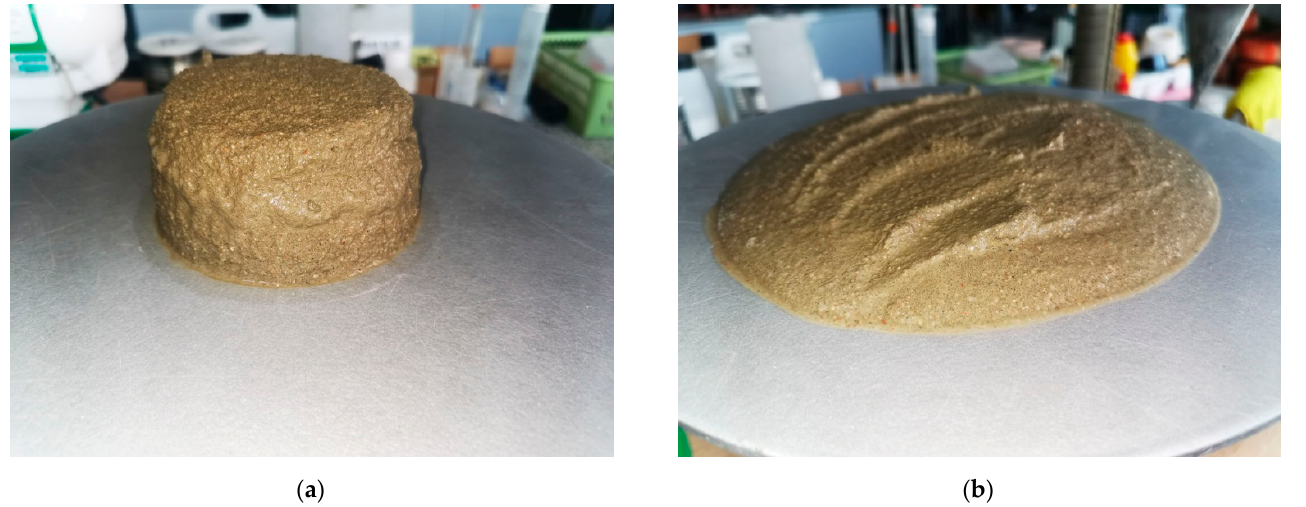
Figure 1. ( a ) View of the C0 sample after removing the form for flow research; ( b ) View of the C0 sample after flow test.